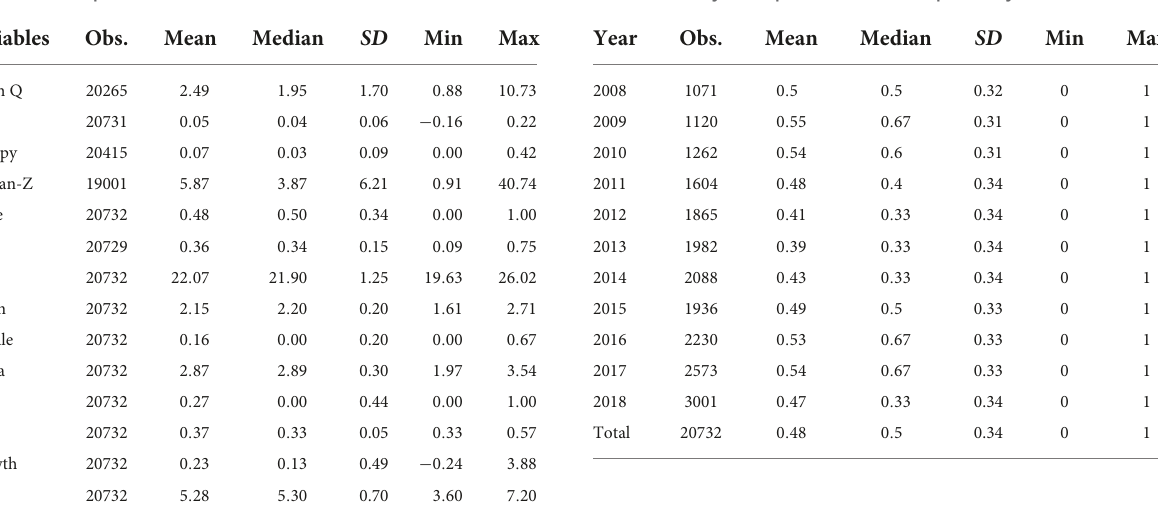
TABLE 2 Descriptive statistics. TABLE 3 Yearly descriptive statistics of explanatory